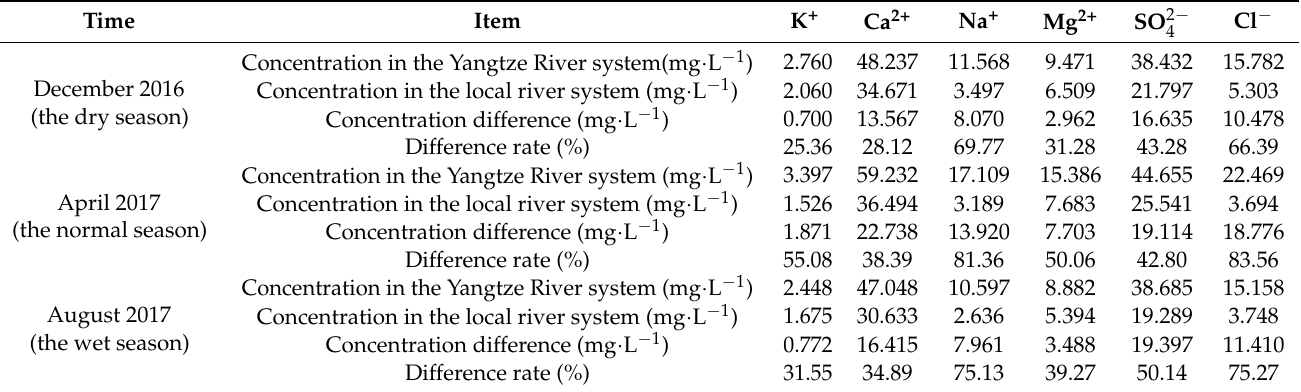
Table 3. Concentrations of major ions and the differences between the local river system and the Yangtze River